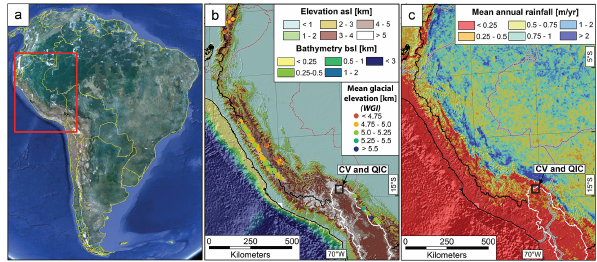
Fig. 1. Location of the study area – (a) South American conti- nent, (b) topography and (c) rainfall for the northern and central Andes. Red rectangle in (a) indicates the area covered in panels (b) and (c) . Included in (b) are some tropical glaciers (colored ac- cording to mean glacial elevation) from the World Glacier Inven- tory (WGMS and NSIDC, 1989), and in (b) and (c) the Amazon drainage basin is denoted by the thin black line, and the northern part of the internally drained Altiplano-Puna Plateau is displayed by a white line. Topography (b) is derived from the Shuttle Radar Topography Mission (SRTM) DEM, and mean annual rainfall (c) is based on satellite-derived estimates using Tropical Rainfall Mea- surement Mission (TRMM) product 2B31 averaged from 1998 to 2010 (Bookhagen and Strecker, 2008, 2012; Bookhagen and Bur- bank, 2010). The small black rectangle in panels (b) and (c) in- dicates the more specific study area of the Cordillera Vilcanota (CV) and the Quelccaya Ice Cap (QIC). Image in (a) is courtesy of Google